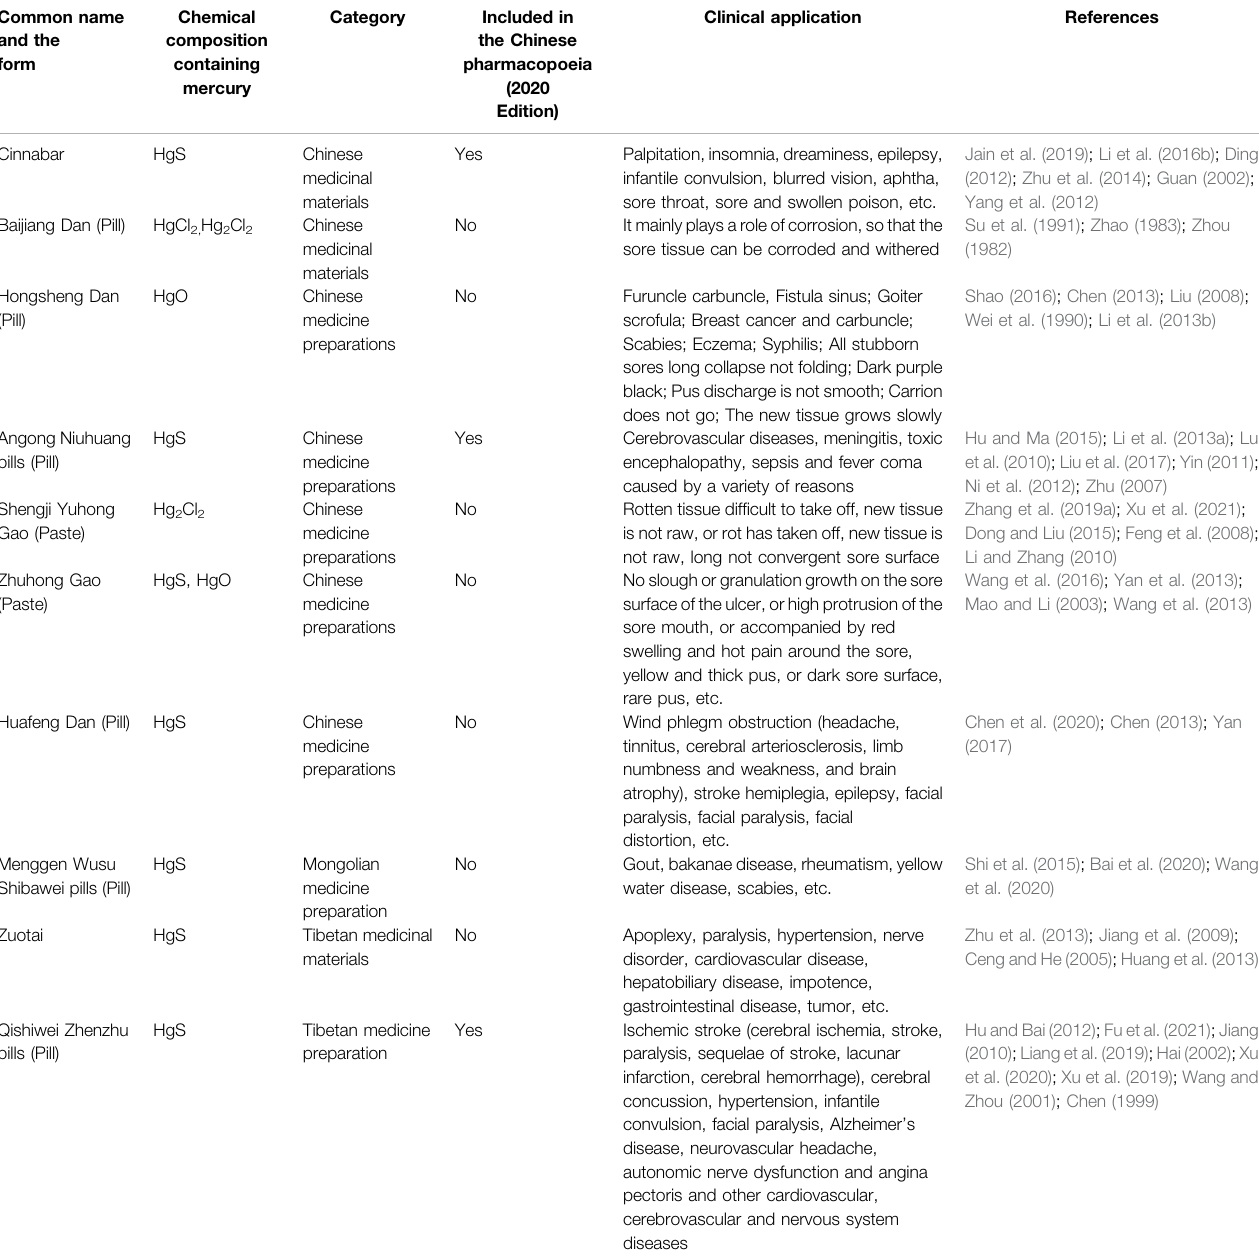
TABLE 1 | Clinical application of mercury and mercury-containing preparations in traditional Chinese